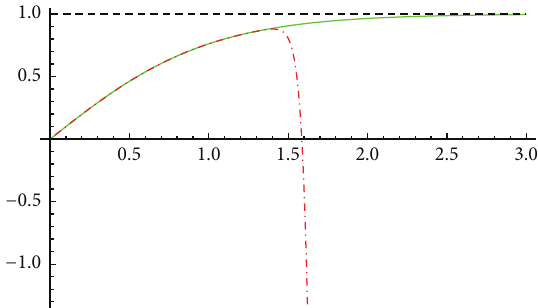
Figure 2: The Pad´e approximant [9/10]{𝜙 20 (𝑥)} (dot-dashed line), far-fieldapproximation 𝜑 7 (𝑥) (dashedline),andexactsolution 𝑢 ∗ (𝑥) (solid line).